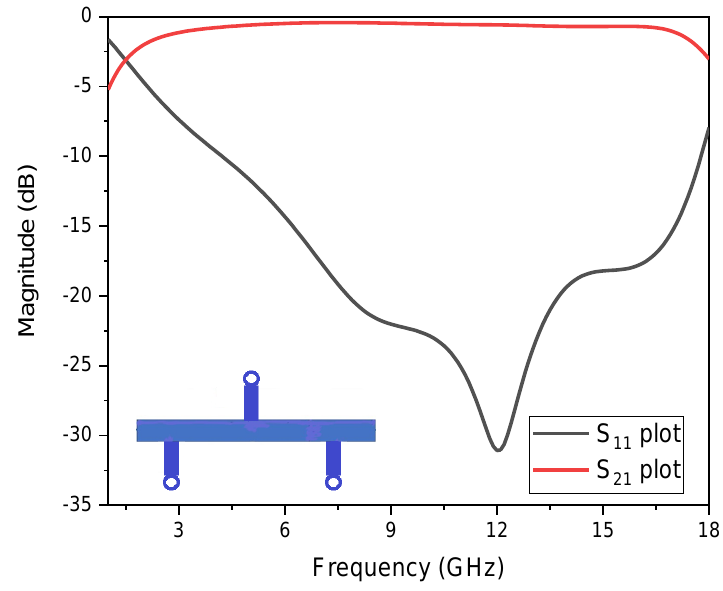
Figure 4. S 11 vs. S 21 frequency plot by loading conventional stub.